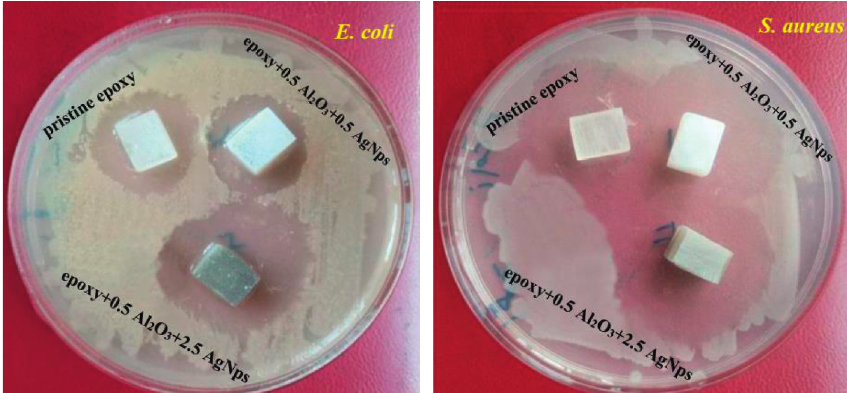
2 O 3 -AgNps against E. coli and